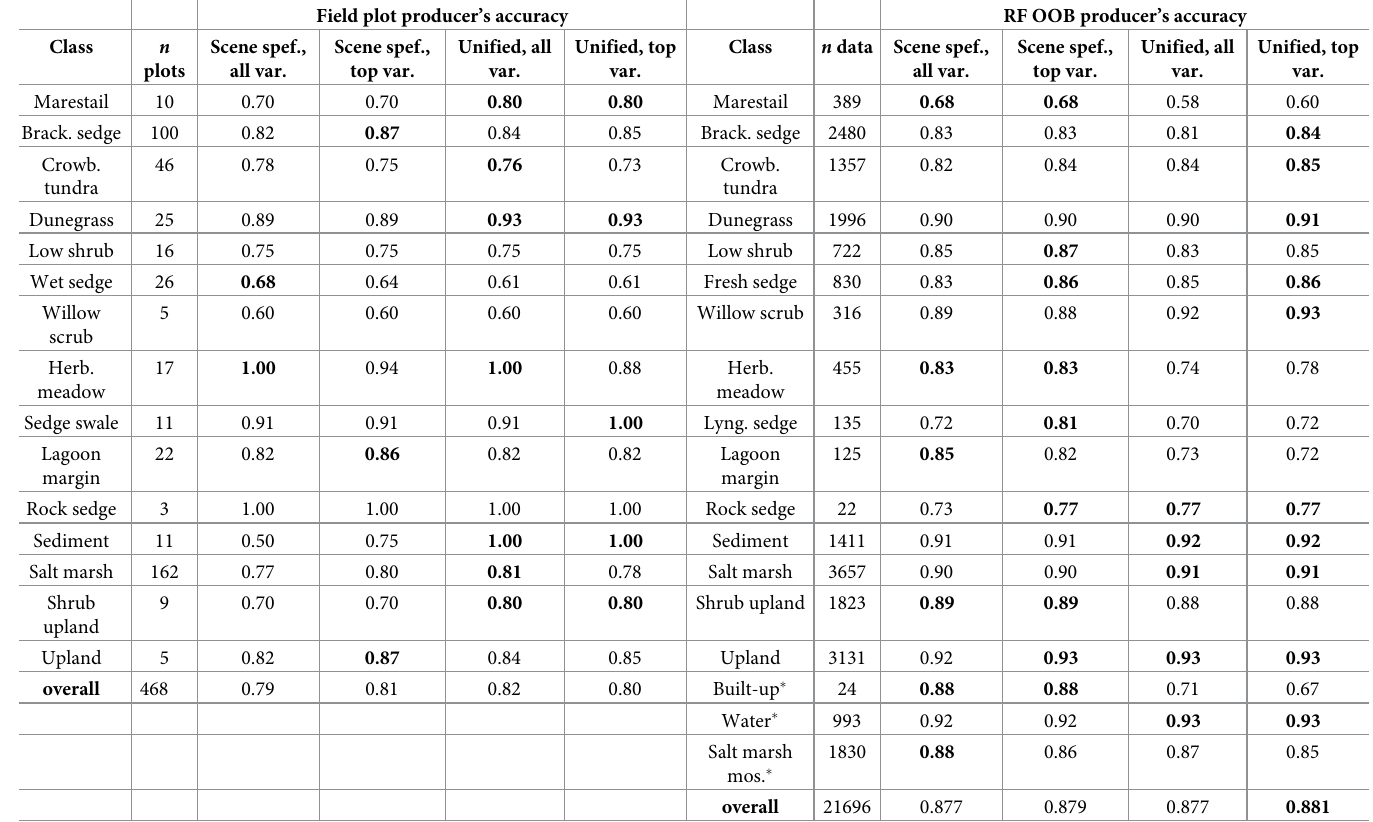
Table 5. The producer’s error for the independent test set of excluded field plots for all four sets of models and out-of-bag producer’s error from each RF